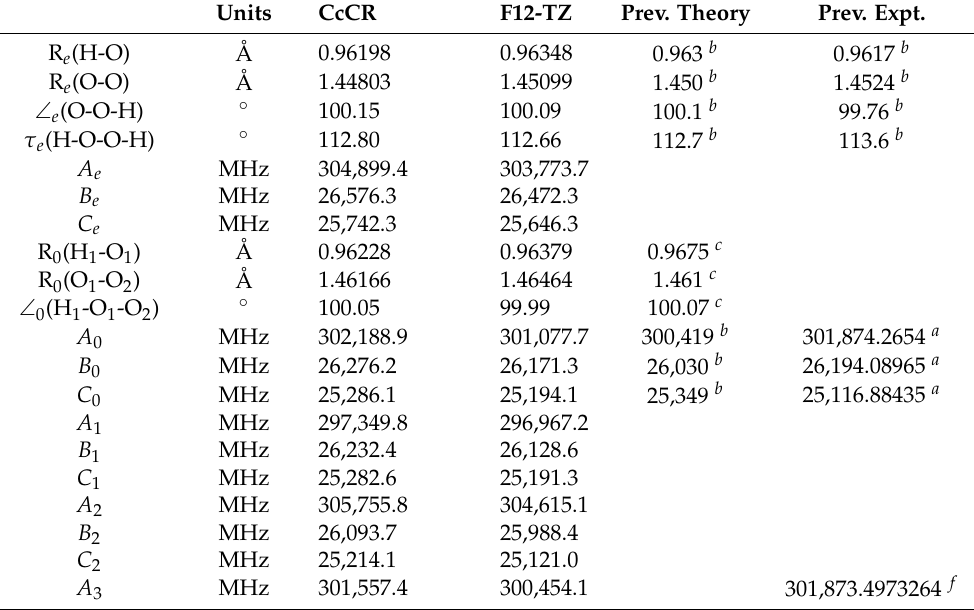
Table 1. Geometrical parameters and spectroscopic constants for HOOH compared to the previous gas-phase